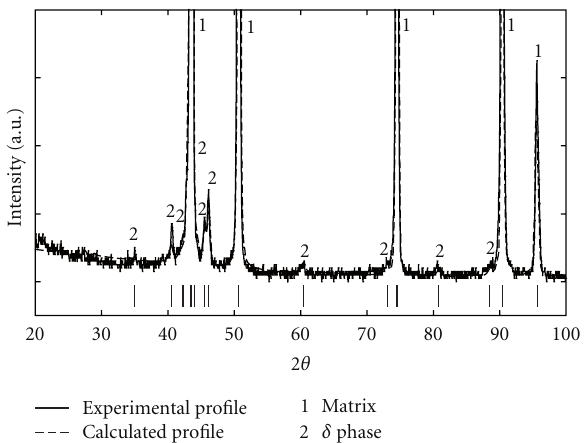
Figure 3: Experimental and calculated X-ray diagram correspond- ing to precipitates extracted from the material. The diagram was calculated after Rietveld refinement according to condition (A).